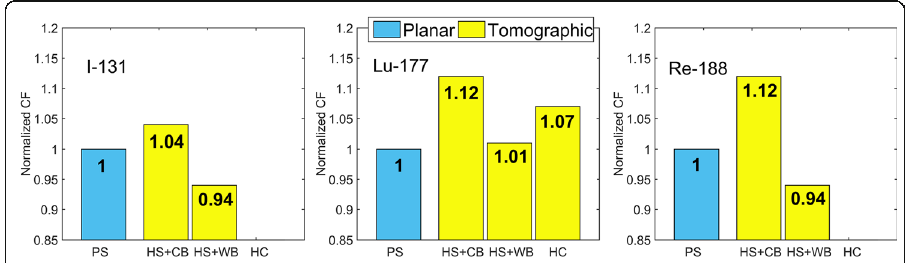
Fig. 3 Summary of CF obtained experimentally using different phantom configurations. The data were normalized using counts in the planar acquisition of a point source corrected for scatter with